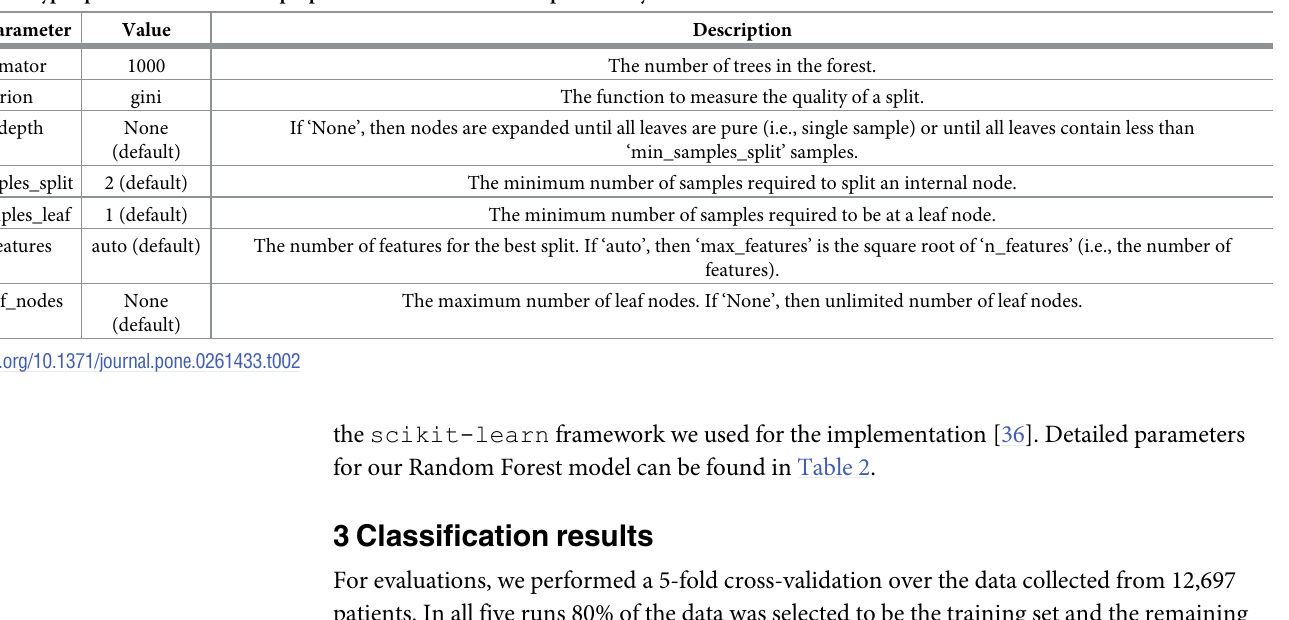
The number of trees in the forest. The function to measure the quality of a